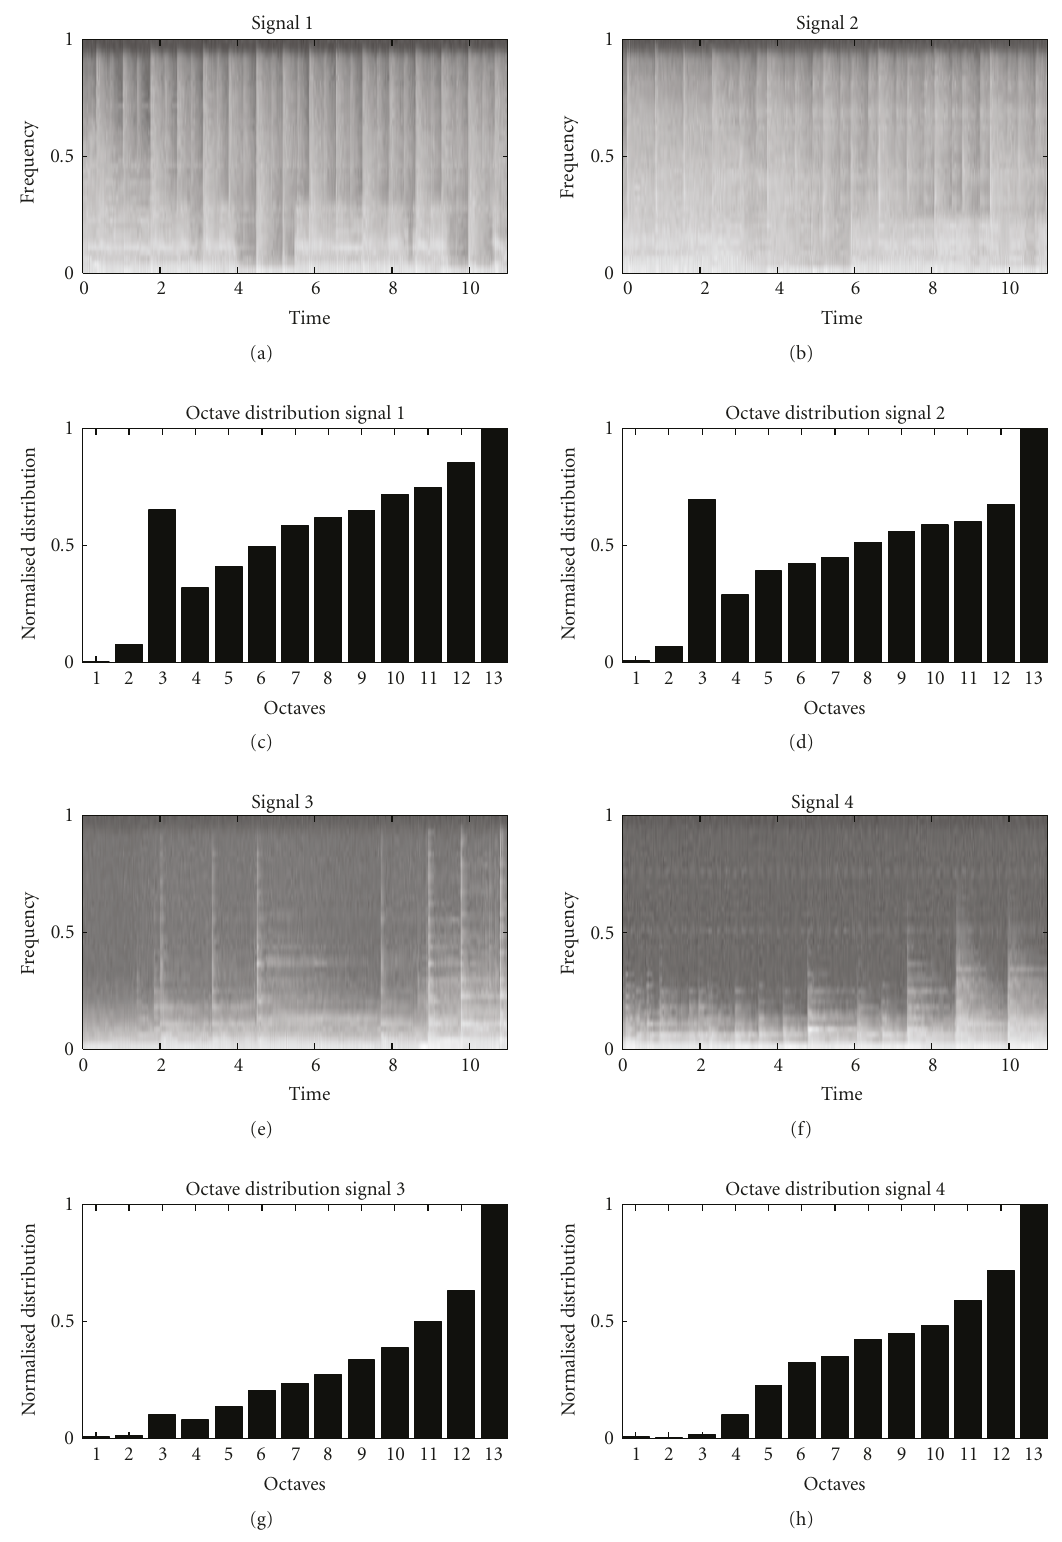
Figure 9: Comparison of octave distributions. Signals 1 and 2: Rock-like signals, and Signals 3 and 4: Classical-like